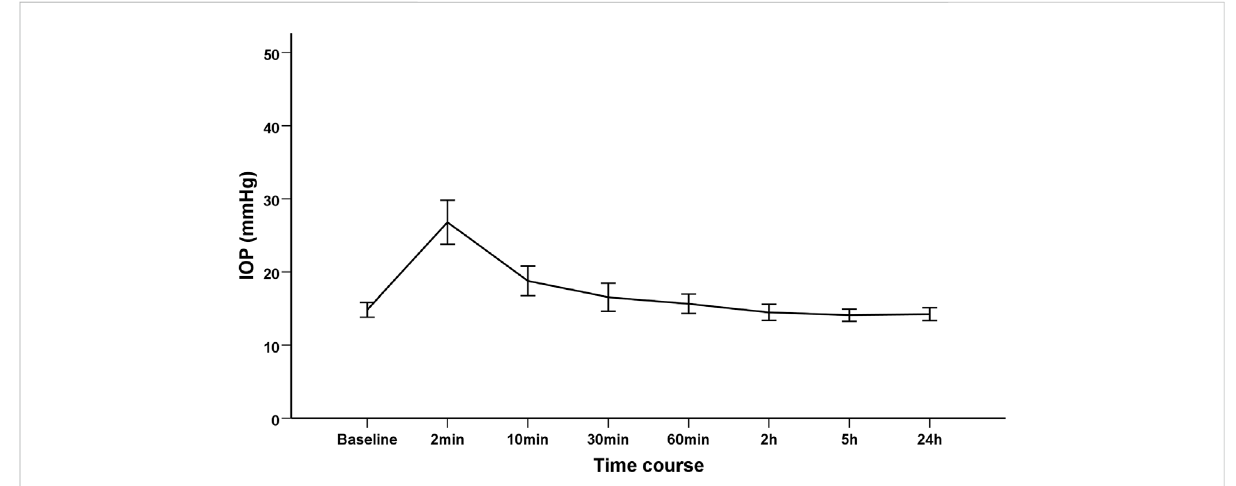
FIGURE 1 The trend of intraocular pressure changes after intravitreal injection of Conbercept in diabetic macular edema